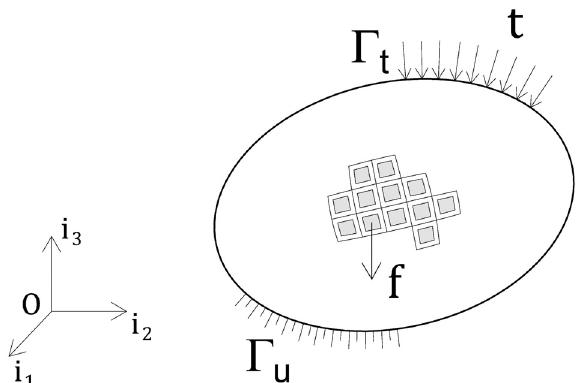
Figure 1: Mechanical scheme of a structure constituted by an heterogeneous